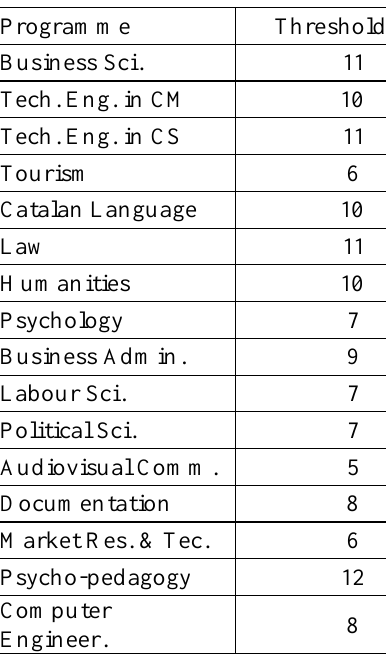
Table 3 Number of Consecutive Semesters that Define Dropout for 1%, 5%, and 10% Error